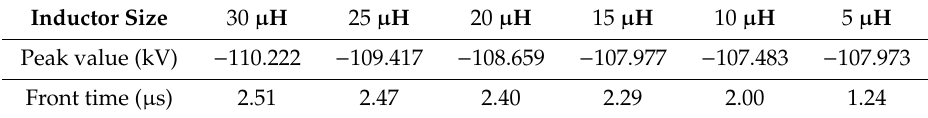
Table 1. E ff ects of di ff erent filter sizes on the overvoltage amplitude 110 kV applied impulse. Inductor Table 1. Effects of different filter sizes on the overvoltage amplitude 110 kV applied impulse.